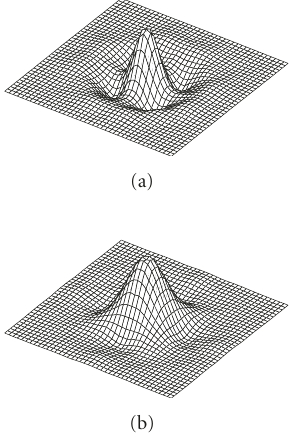
Figure 11: The (a) primal wavelet and (b) primal scaling functions for OPT3.